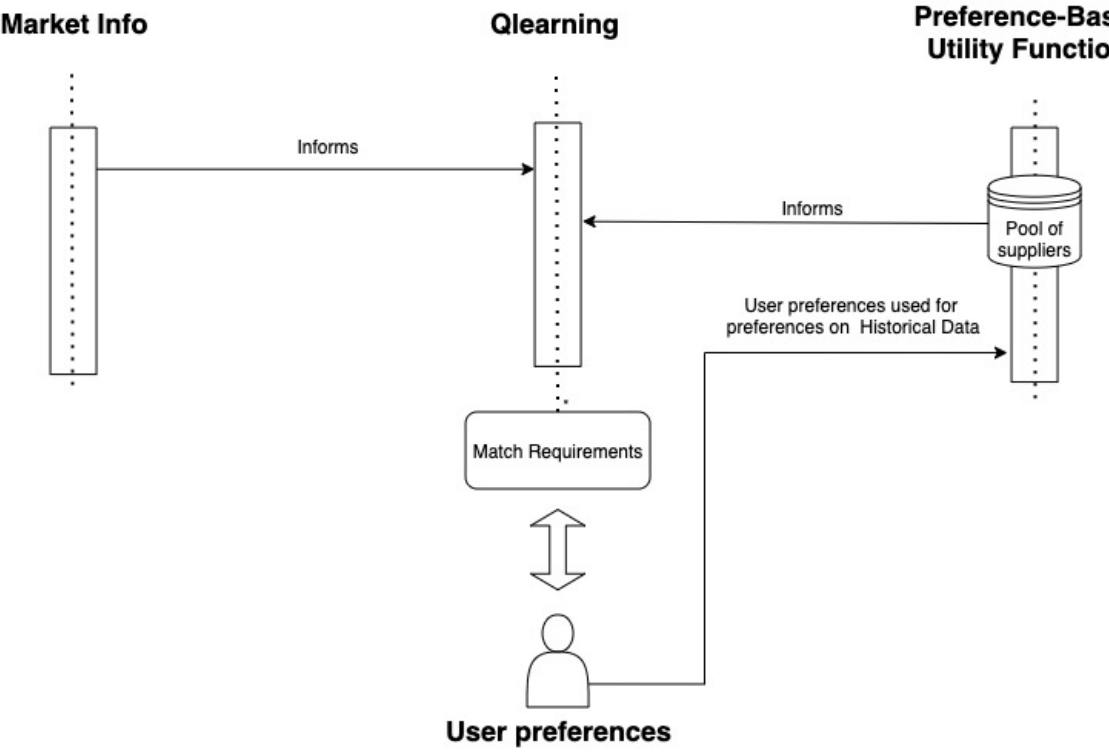
Figure 1. Proposed multi-agent